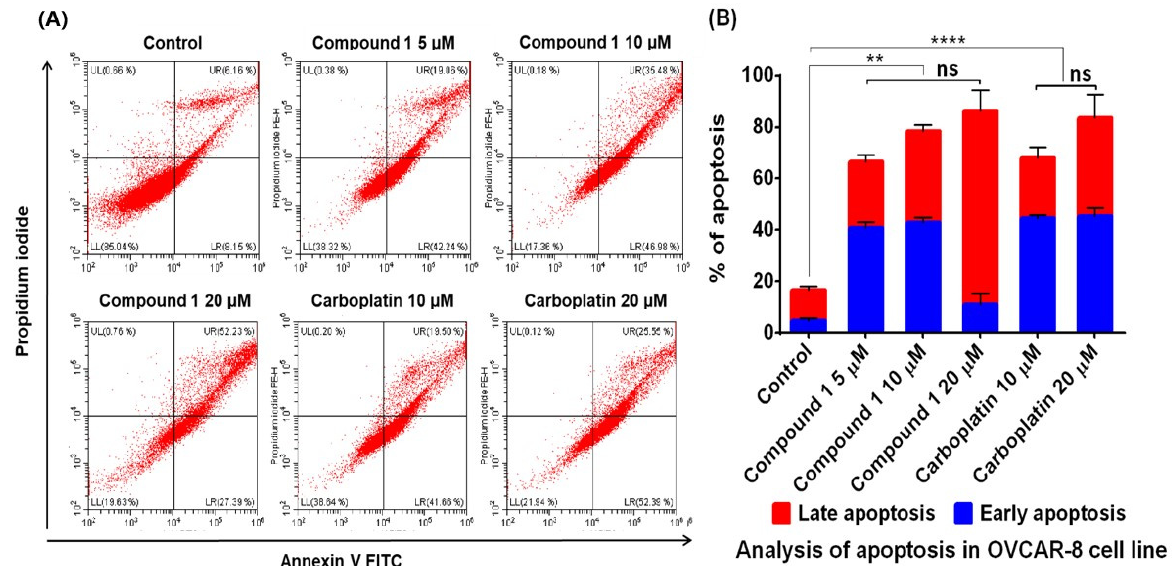
Figure 4. Evaluation of apoptotic activities of compound 1 (5, 10 and 20 μ M) and carboplatin (10 and 20 μ M) on OVCAR-8 cells using annexin V-FITC and propidium iodide (PI) staining analysed with flow cytometry. ( A ) Representative flow cytometry graphs of OVCAR-8 cell line. Lower left (LL), upper left (UL), lower right (LR) and upper right (UR) represent live cells, necrotic cells, cells in early apoptosis and cells in late apoptosis respectively. ( B ) Mean percentage of apoptotic cell populations. The data represent the mean ± SD of three repeats. The significant different between control and treatment is denoted with asterisk (*), while no significant different is denoted with (ns).